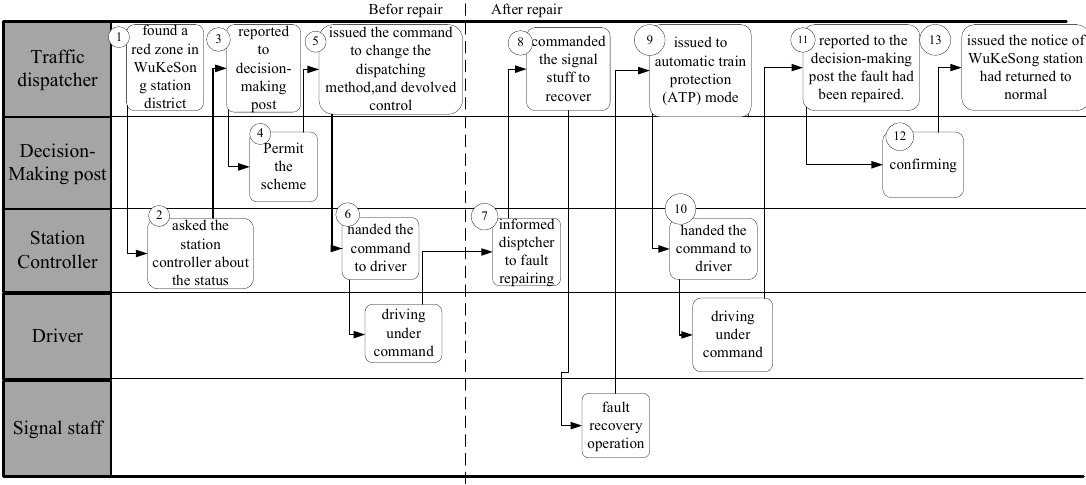
Figure 2. Workflow of team members in situation of signal failure.